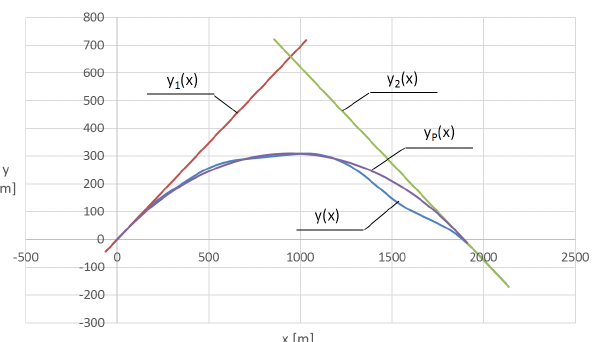
Figure 6: The existing and the designed geometric system in the local system of coordinates (variant II, using the non-isometric scales); y ( x ) – the existing course of the route, y 1 ( x ) and y 2 ( x ) – determined main directions of the route, y P ( x ) – designed course of the route.